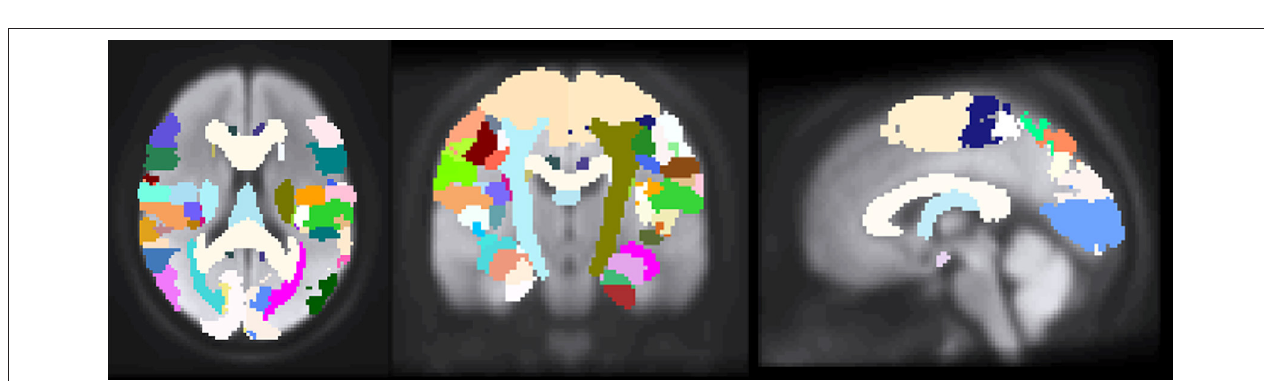
FIGURE 2 | The images depict axial, coronal and sagittal slices of a normalized brain with the overlapped Juelich histological atlas. Both gray and white matter structures can be seen.